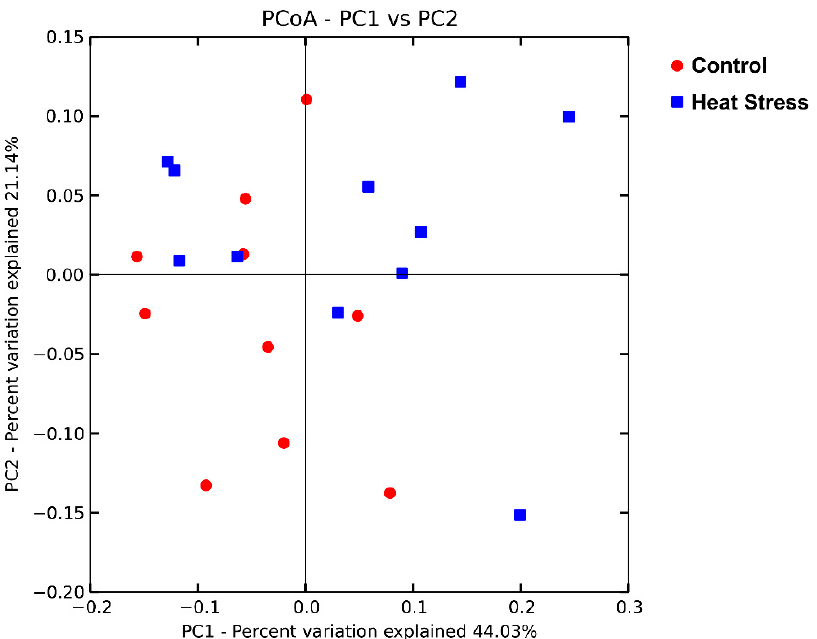
Figure 3. Principal coordinate analysis of the effect of heat stress on the rumen bacterial community based on the weighted UniFrac distance.